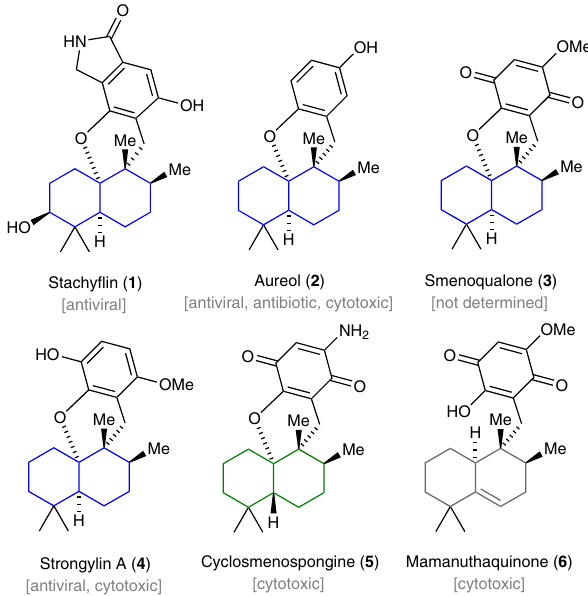
Fig. 1 Selected members of polycyclic meroterpenoids and their reported biological activity. Within this subclass of natural products, two distinct stereochemistries with respect to the decalin subunit have been